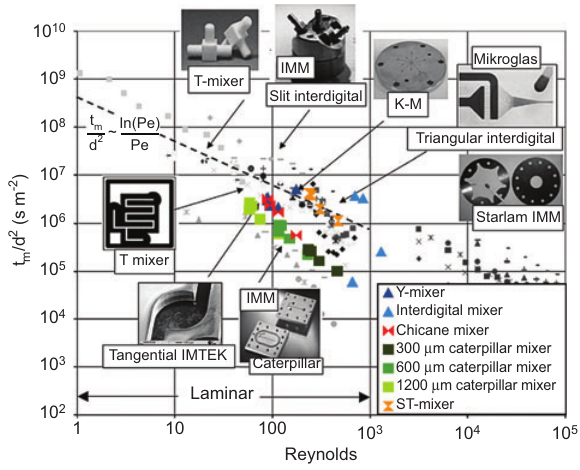
Figure 10 Mixing times normalised by the square of the character- istic fl ow dimension as a function of the Reynolds number. The results from this work (coloured symbols) were integrated into the results from Falk et al. (Reprinted with permission from Elsevier) [40].